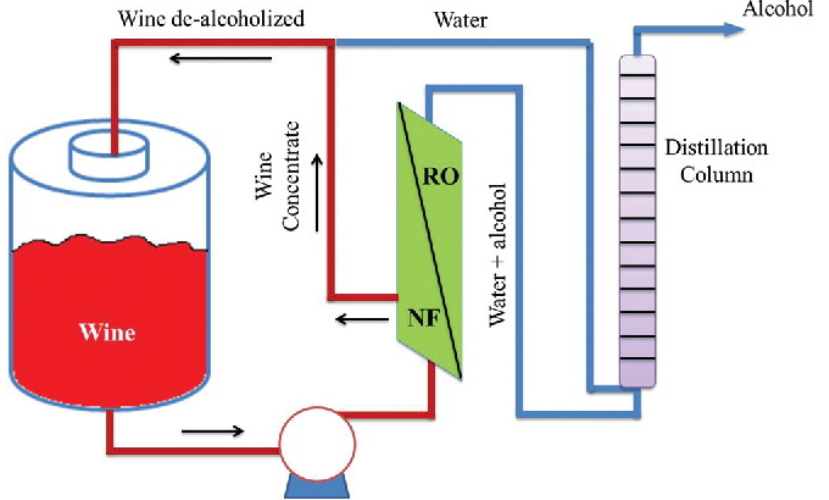
Figure 7. Process of wine de-alcoholization by coupling reverse osmosis or nanofiltration and distillation. Reprinted from [163], with permission from Taylor and Francis Ltd., http://www.tandfonline.com (accessed on 14 October 2021).